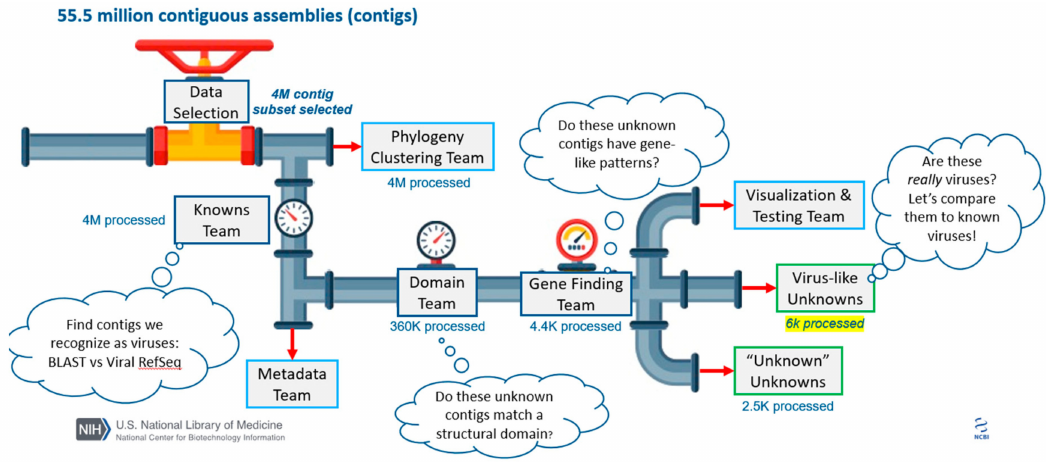
Figure 1. Overview of hackathon teams and data processing. All numbers detail the number of contigs processed at each step of the pipeline. A subset of ~3000 data sets were assembled, generating 55.5 million total contigs. Researchers attending the hackathon assembled into teams that roughly correspond to goals outlined in the Methods and Results. Members of the “Knowns Team” excluded contigs based on size (removing < 1 kb in length) and the remaining ~4 million contigs were assigned classification to known viruses using a BLASTN search against the RefSeq Virus database (Sections 2.3 and 3.3). Independently, members of the “Phylogeny Clustering Team” clustered ~4 million contigs using Markov Clustering techniques (Section 2.4). Members of the “Metadata Team” used machine learning approaches to build training sets that could be used to correlate sequences to sample source metadata (Sections 2.7 and 3.7). Members of the “Domain Team” predicted functional domains with RPSTBLASTN and the CDD database using ~360,000 contigs that were not classified using the RefSeq Virus database (Sections 2.5 and 3.3). Members of the “Gene Finding Team” predicted